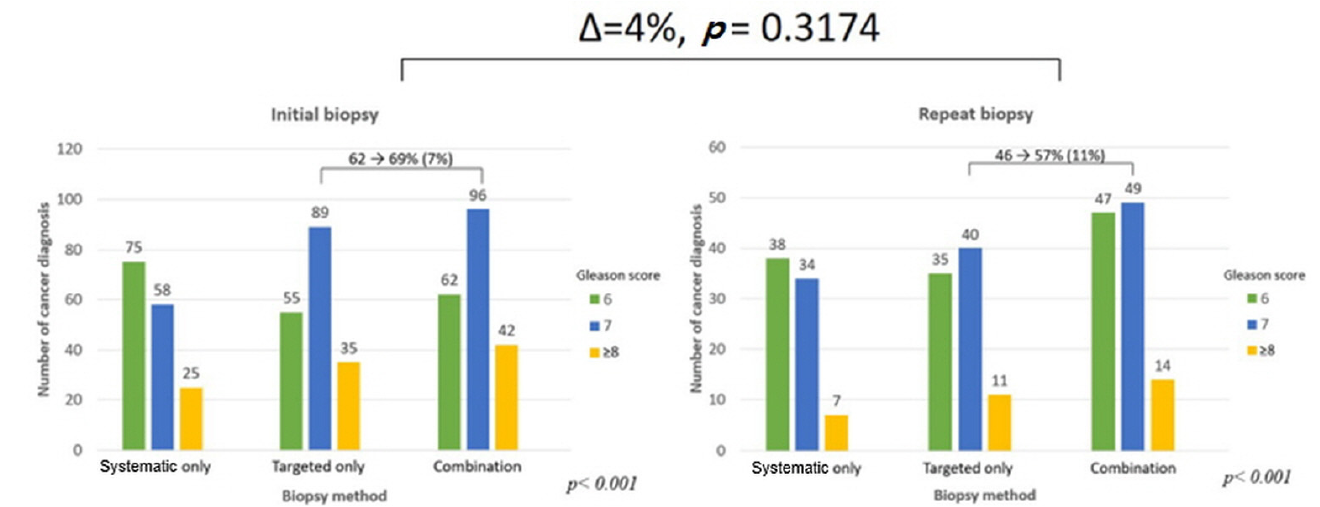
Figure 2. Cancer diagnosis core number in the initial and repeat biopsy settings.